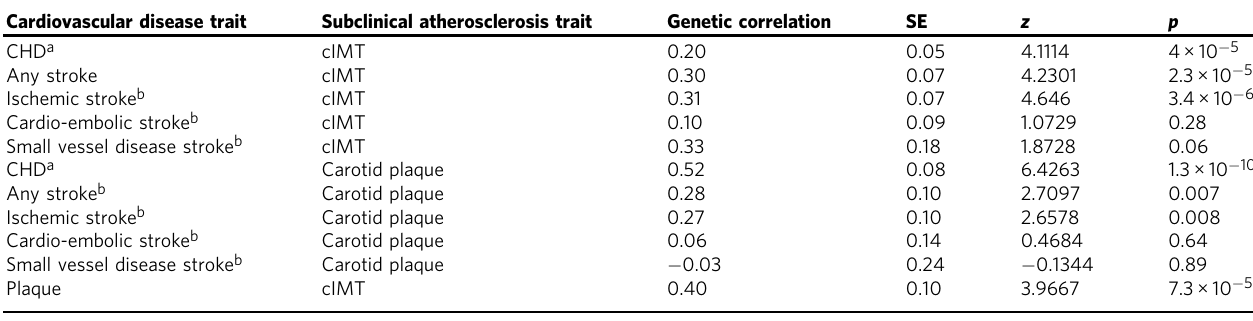
Table 4 Genetic correlation between CHD and stroke traits with cIMT and plaque, and cIMT with plaque using LD score and